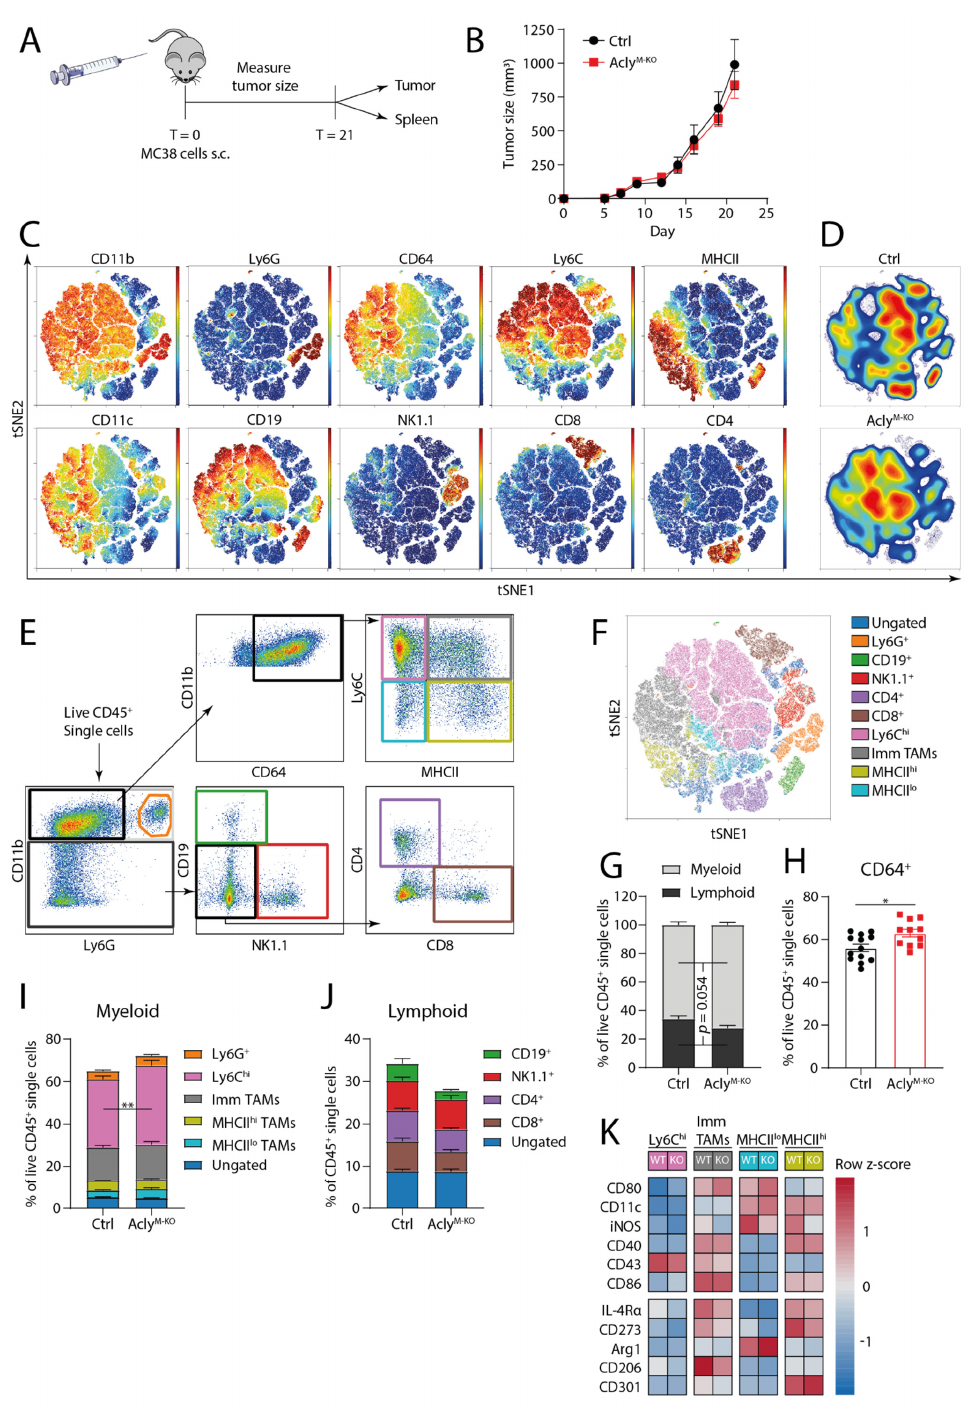
Figure 2. Acly M-KO macrophages do not improve in vivo anti-tumor responses in an MC38 tumor model. ( A ) MC38 colon carcinomas were subcutaneously injected and grown for 21 days. ( B ) Growth curves of MC38 tumors for Acly fl/fl Ctrl and Acly M-KO mice. ( C ) Unsupervised clustering analysis of live CD45 + single cells isolated from MC38 tumors. ( D ) Density distribution for control and Acly M-KO mice over the unsupervised clustering. ( E ) Manual gating strategy of different immune cell populations. ( F ) Overlay of manually gated populations from ( E ) on unsupervised clustering in ( C ). ( G ) Percentages of CD11b + or CD11b − cells of live CD45 + single cells. ( H ) Percentage of CD64 + of live CD45 + single cells. ( I ) Percentages of myeloid or ( J ) lymphoid cell populations live CD45 + single cells. ( K ) Heatmap of pro- and anti-inflammatory macrophage marker protein expression in Ly6C hi , Immature TAM, MHCII lo and MHCII hi TAM populations as measured by FACS. For F-K, colors match the colors used for manual gating in ( E ). p -values are indicated as <0.05 *, <0.01 **. Results are shown as mean ±